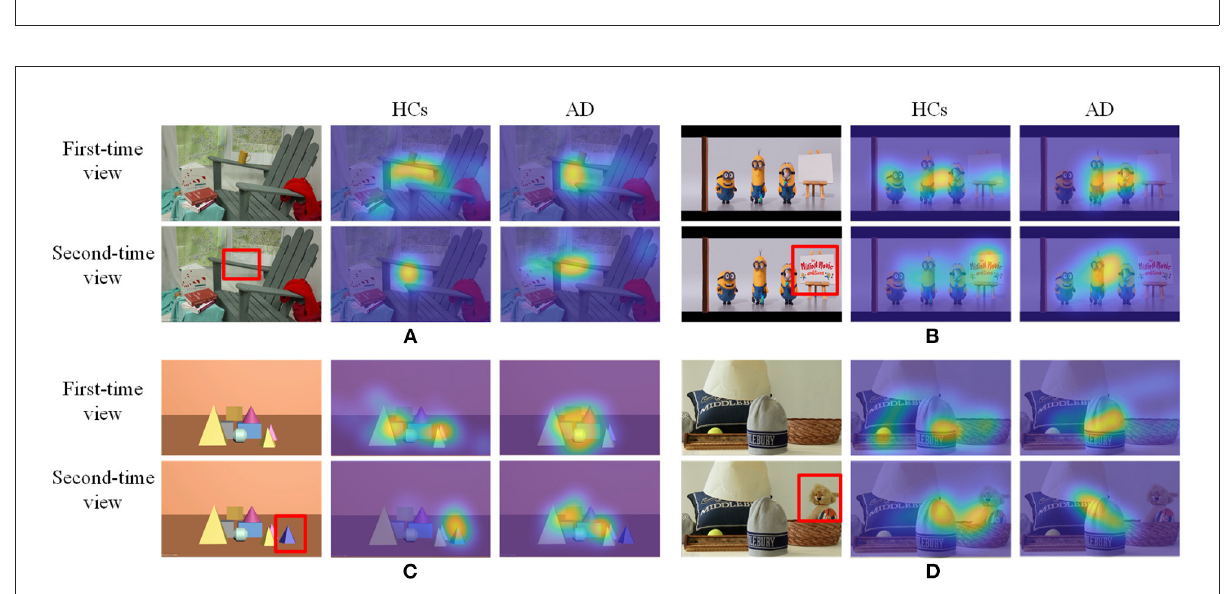
FIGURE3 Some samples of the testing images and corresponding fixation heatmaps generated for each group and each time viewing. (A) Indoor far-view scene; (B) Cartoon scene; (C) Geometric scene; (D) Indoor near-view